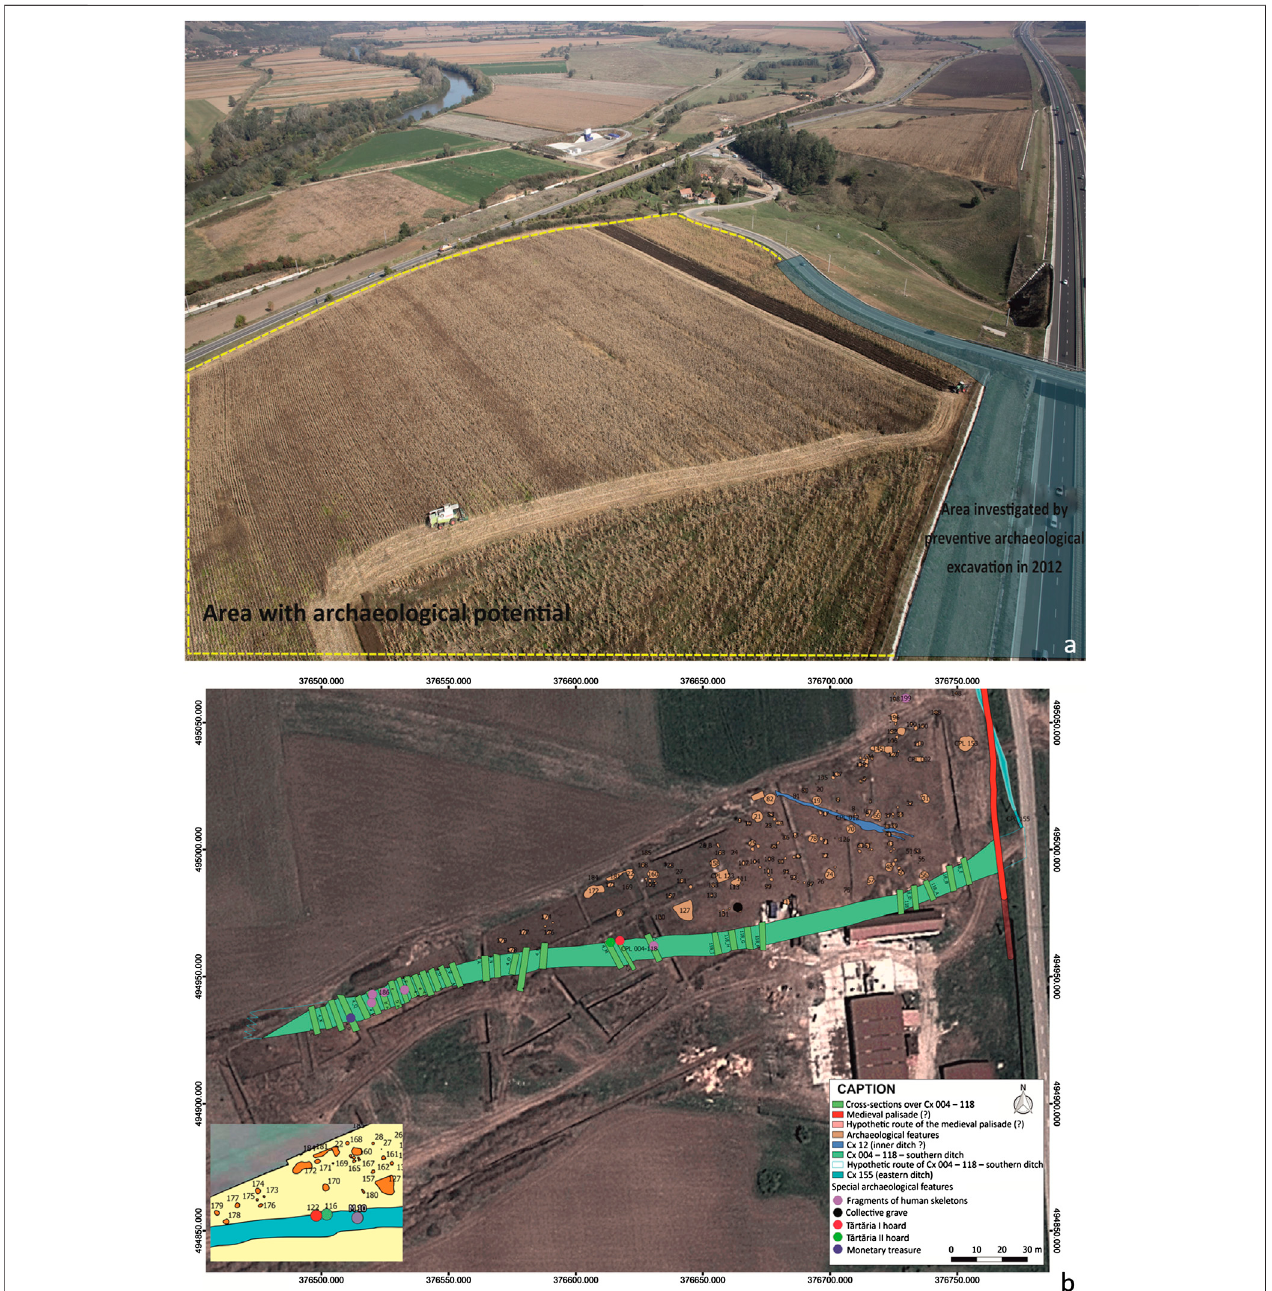
FIGURE 1 | (A) the position of T ˘ art ˘ aria archaeological site; (B) location of the archaeological material within the boundaries of archaeological site T ˘ art ˘ aria – Podu T ˘ art ˘ ariei vest.